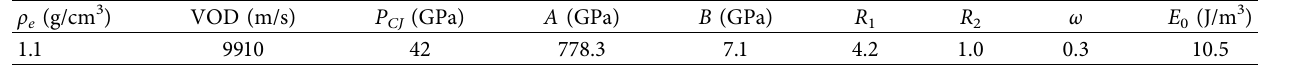
Table 1: Properties of the explosive (HMX) and the JWL state